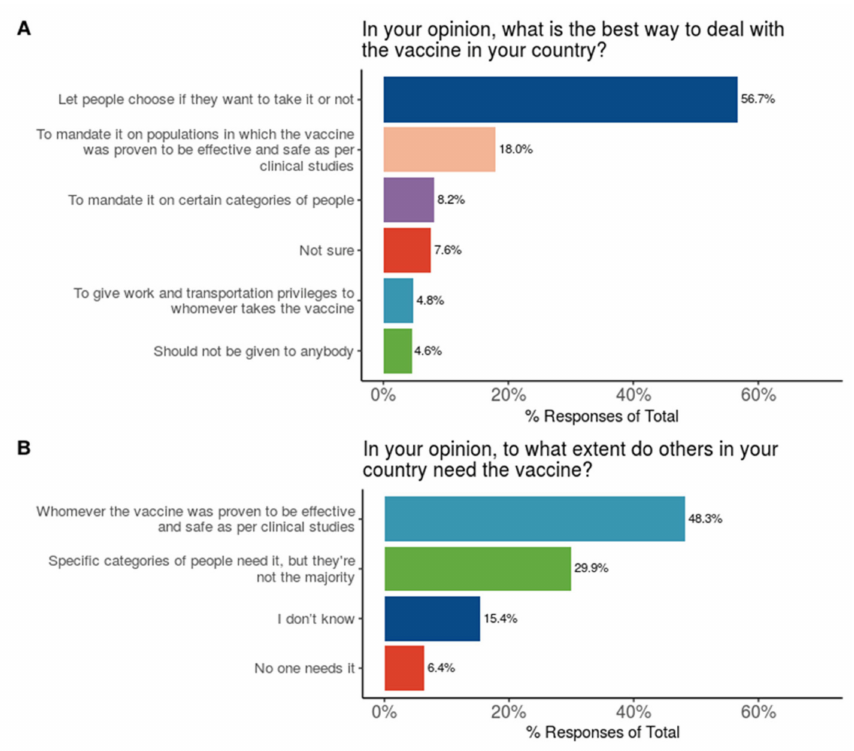
Figure 6. Participants’ attitudes towards COVID-19 vaccination with regards to ( A ) national health policies, and ( B ) selecting individuals who should be